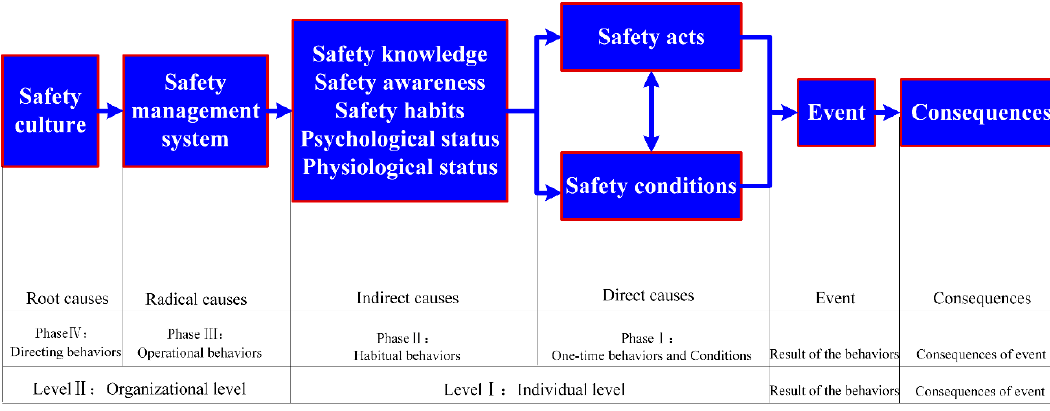
Figure 3. 24Model [35]. Figure 3. 24Model